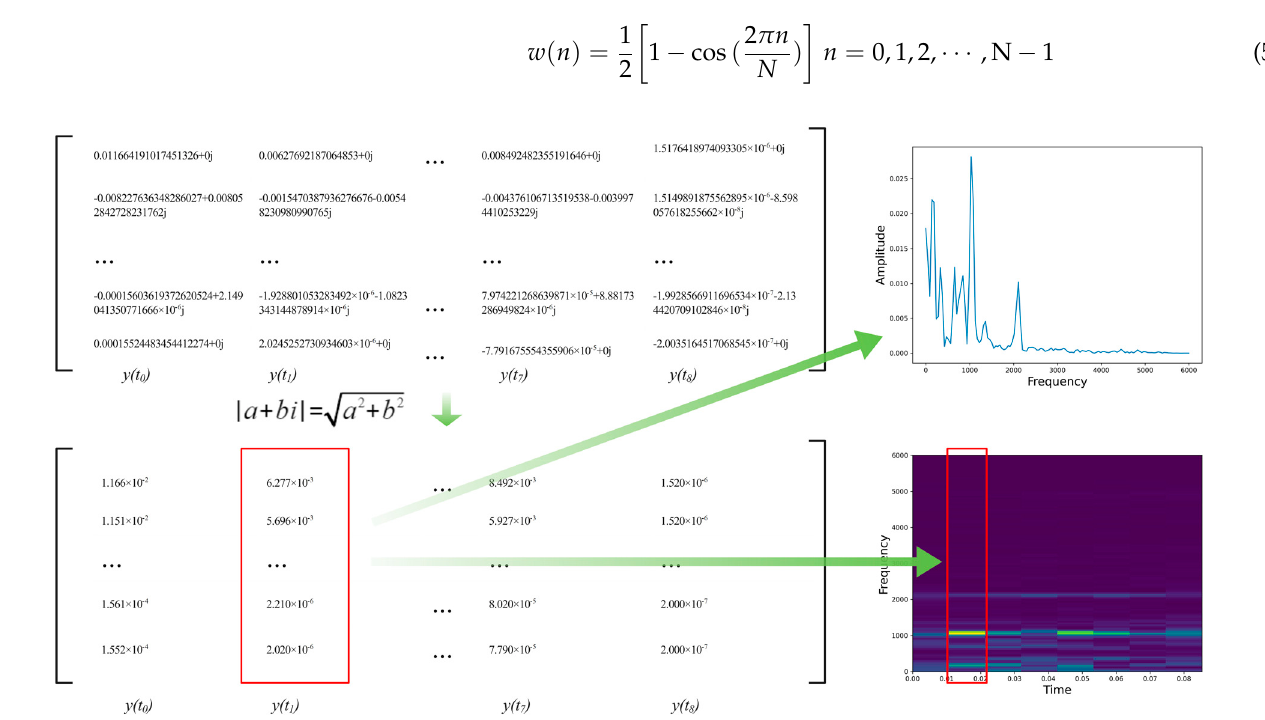
Figure 6. The process of generating a spectrogram from the result of short-time Fourier transform.